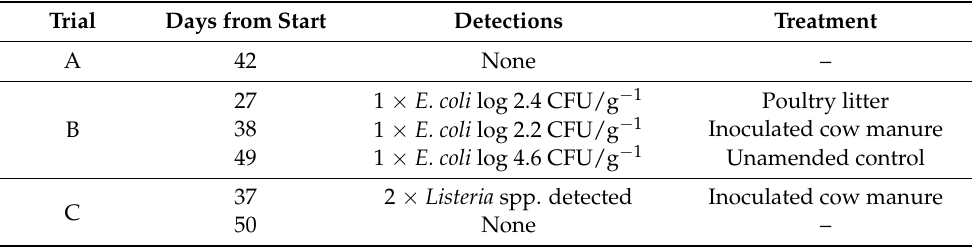
Table 5. Detections of human pathogens on harvested lettuce, n = 40 heads/sampling time.